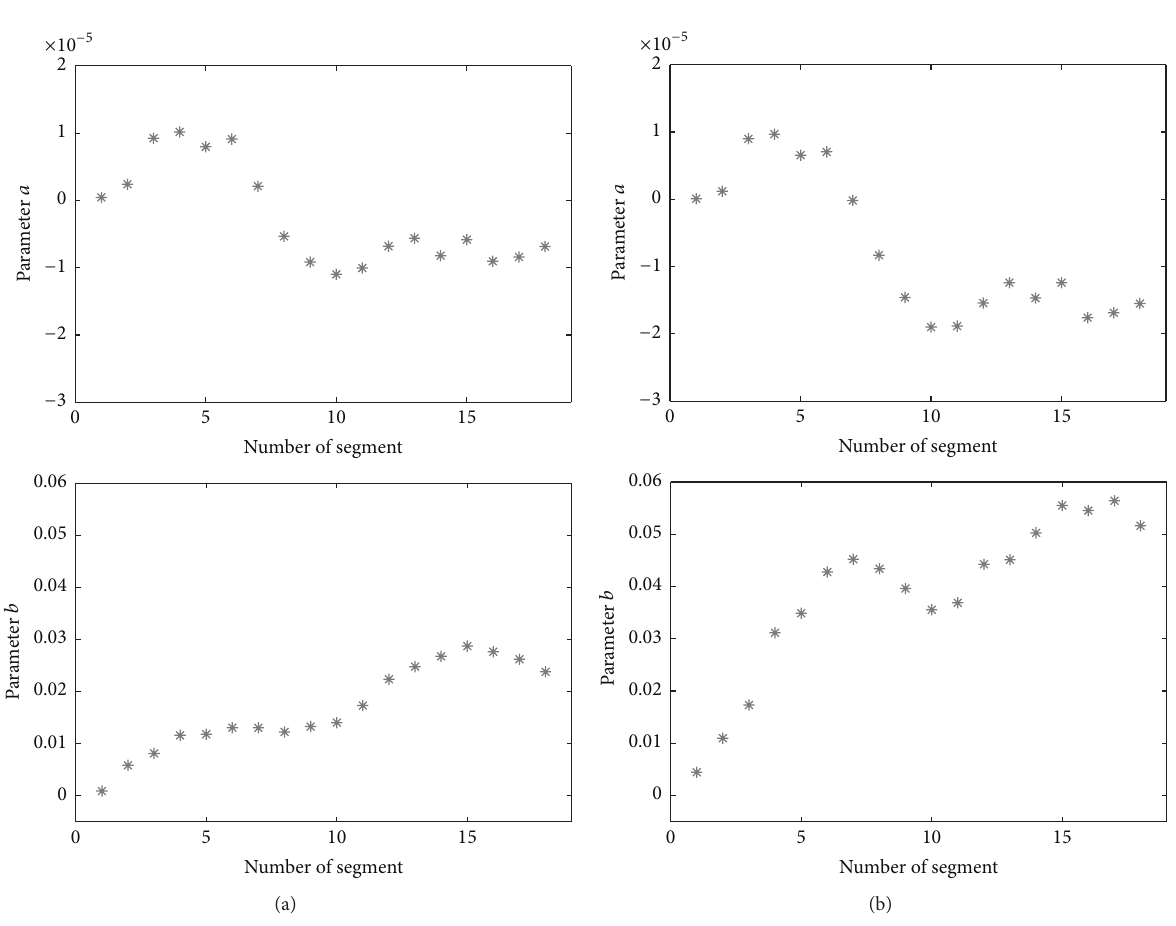
Figure 10: Fluctuation of parameters 𝑎 and 𝑏 obtained for consecutive segments of estimation error on RMS over power (a) and rotational speed